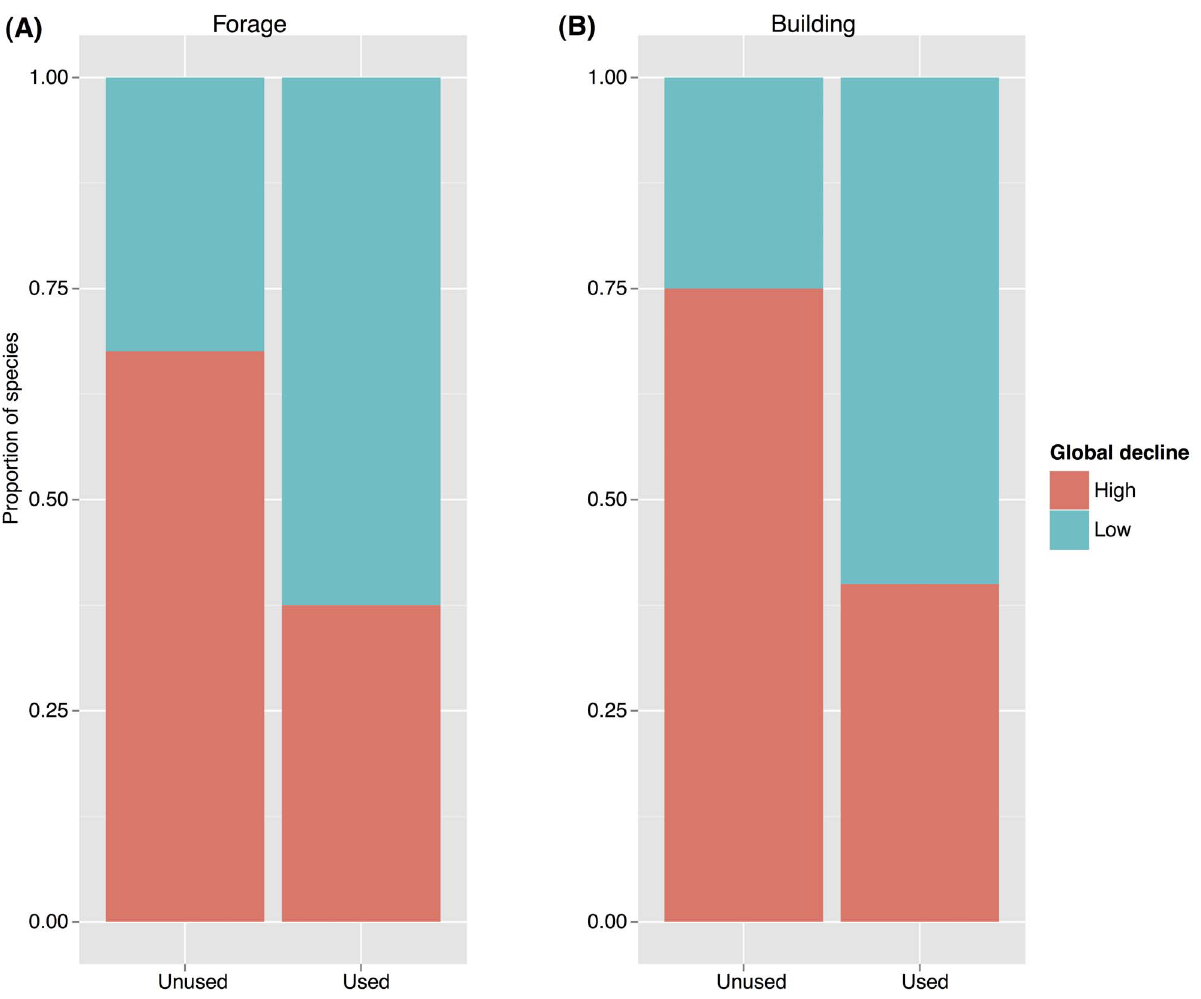
Figure 3. Stacked histograms of the proportion of species declining globally when used for (A) structural building, and (B) forage.